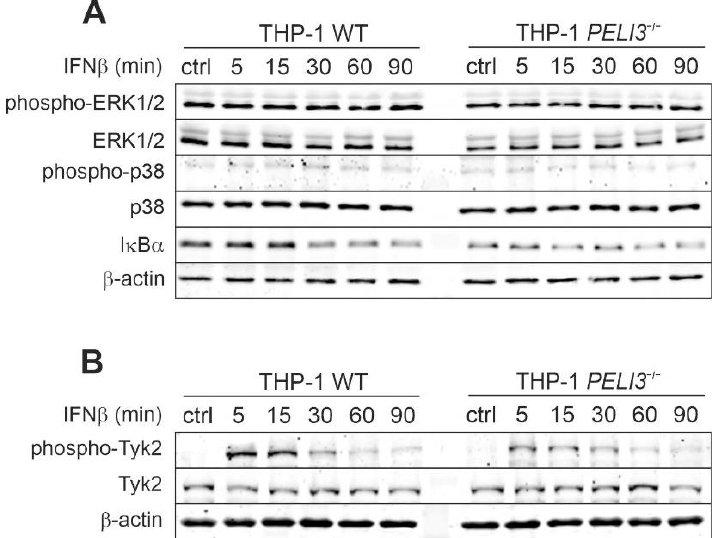
Figure 2. Pellino3 regulates IFNβ -induced Tyk2 phosphorylation. ( A , B ) Wild type (WT) and PELI3 −/− THP-1 cells were treated with IFN β (1000 U/mL) for indicated time periods. Whole-cell lysates were subjected to SDS-PAGE followed by Western blotting. Protein detection was performed using specific antibodies and appropriate secondary antibodies conjugated to the fluorescent dye in the infrared range. Visualization was performed using the Odyssey CLx Imaging System LI-COR. The results presented are representative of at least three independent experiments.